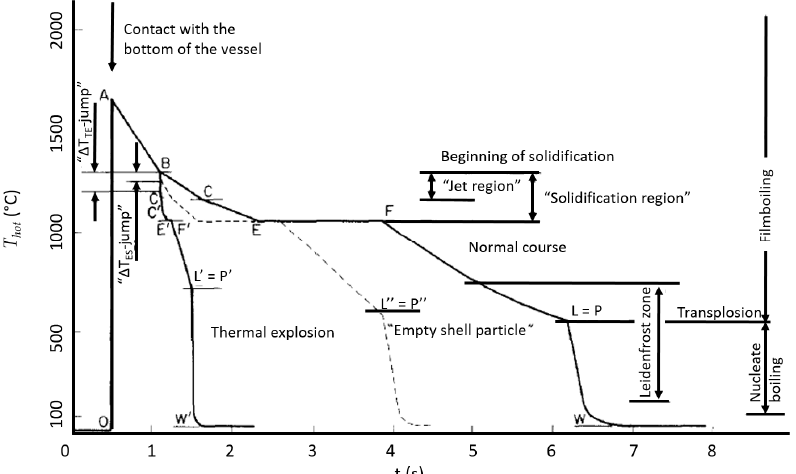
Figure 2. Possible cooling curves (temperature of the hot phase ( T hot ) measured at the bottom (Y-axis) versus time (X-axis)) for 1 g of molten copper in water (adapted from Reference [48]).